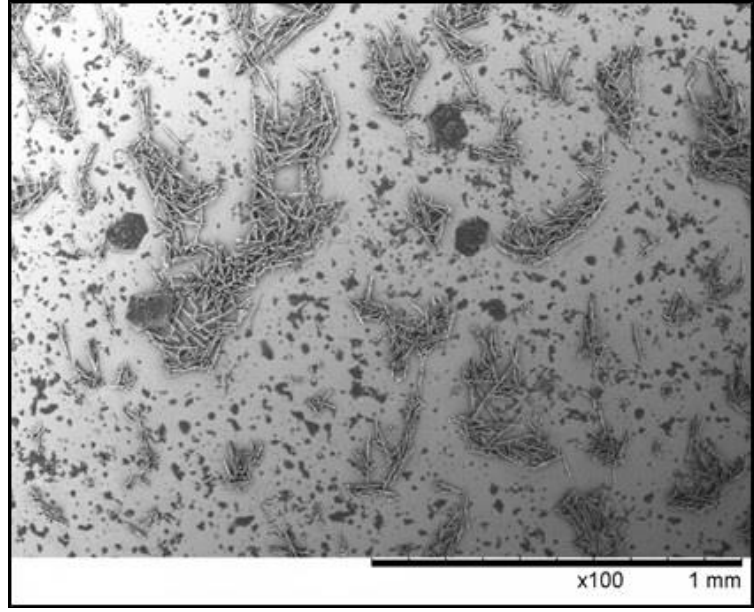
Figure 6. Glass substrate treated with Neodol & SBA-15 and then sprayed with oily dirt. The dirt stays, black spots, onto the substrate and pushes the coating to form larger agglomerates.